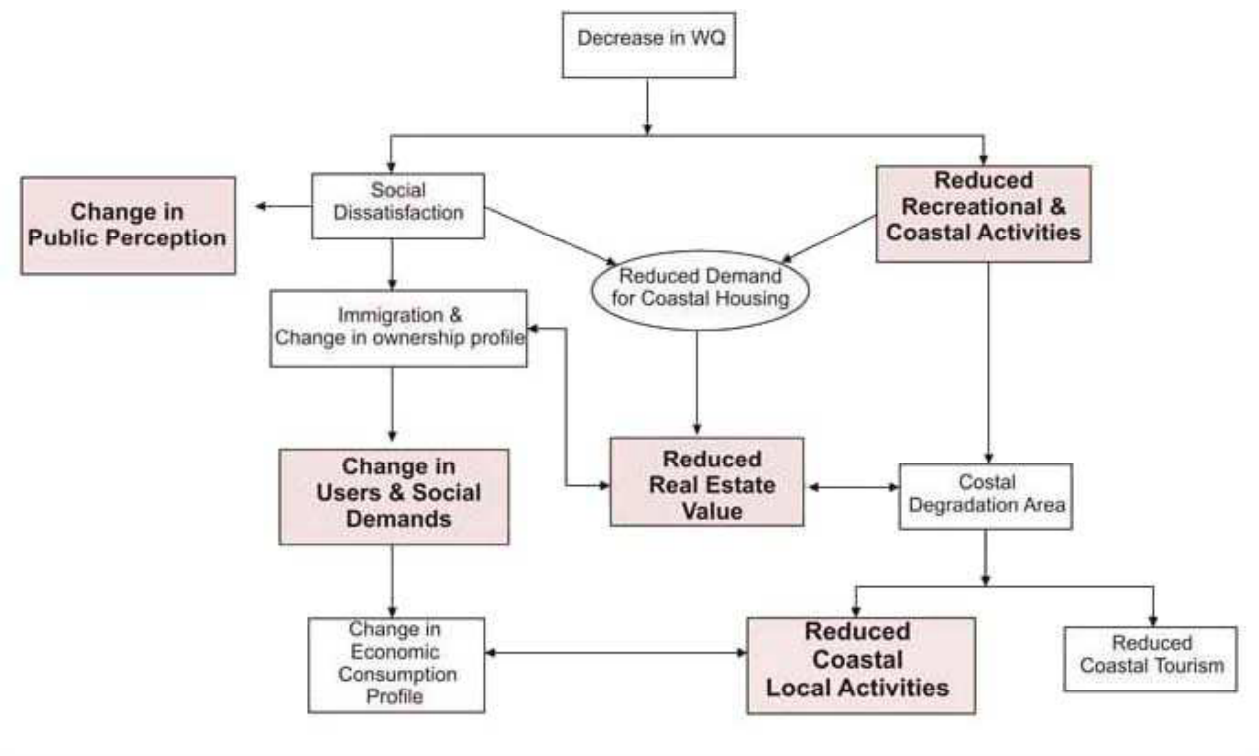
Fig. 7. Conceptual diagram of the social and economic model for the Izmit Bay coastal